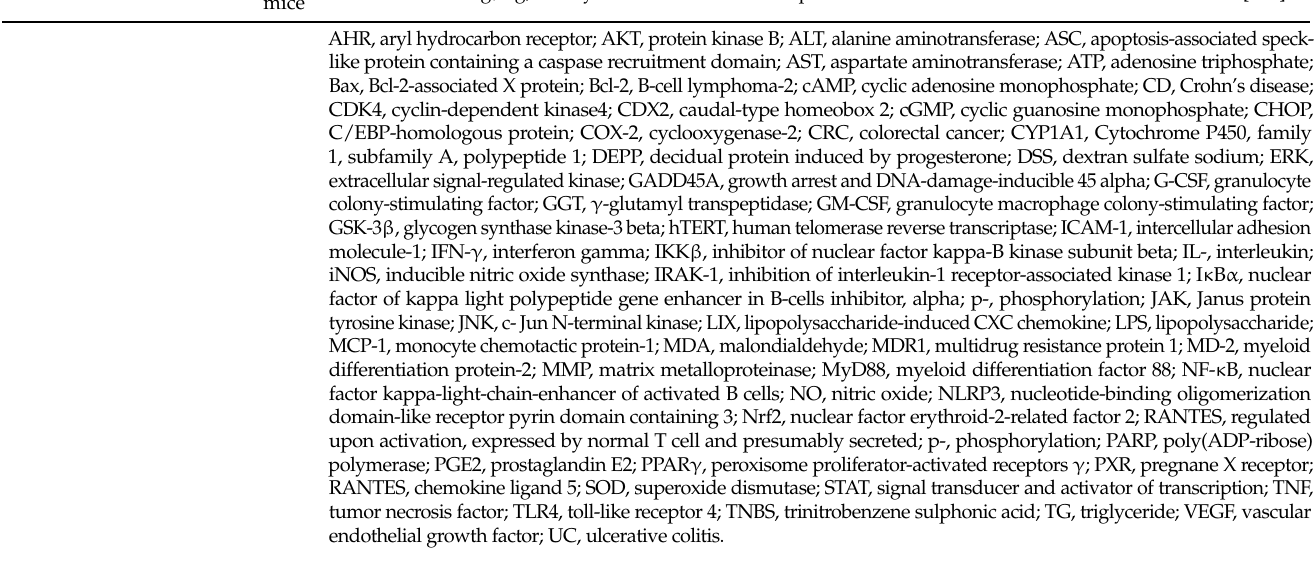
Table 3. The effect of wogonoside on inflammatory bowel disease and colorectal